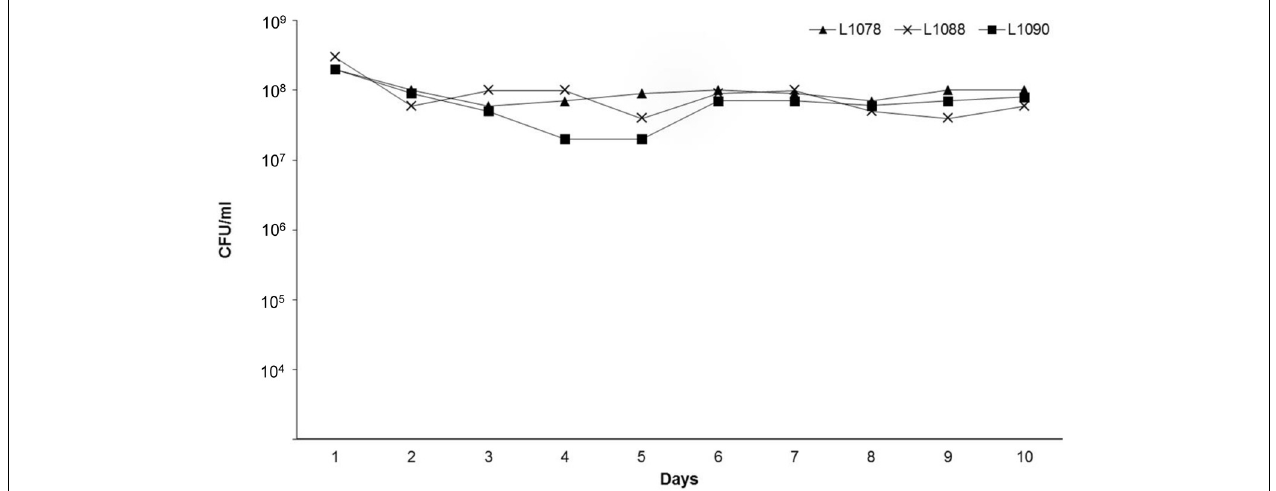
FIGURE 1 | Stability of the commensal E. coli lysogens L1078, L1088, and L1090 during 10 cultural passages in LB broth without chloramphenicol. After each passage, the bacterial cultures were examined for loss of prophage by determining the number of Cm resistant colonies (CFU/ml).